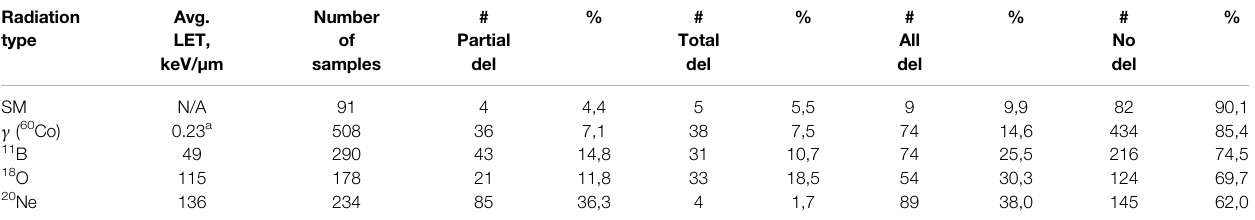
TABLE 3 | Results of the HPRT gene structural analysis. Radiation